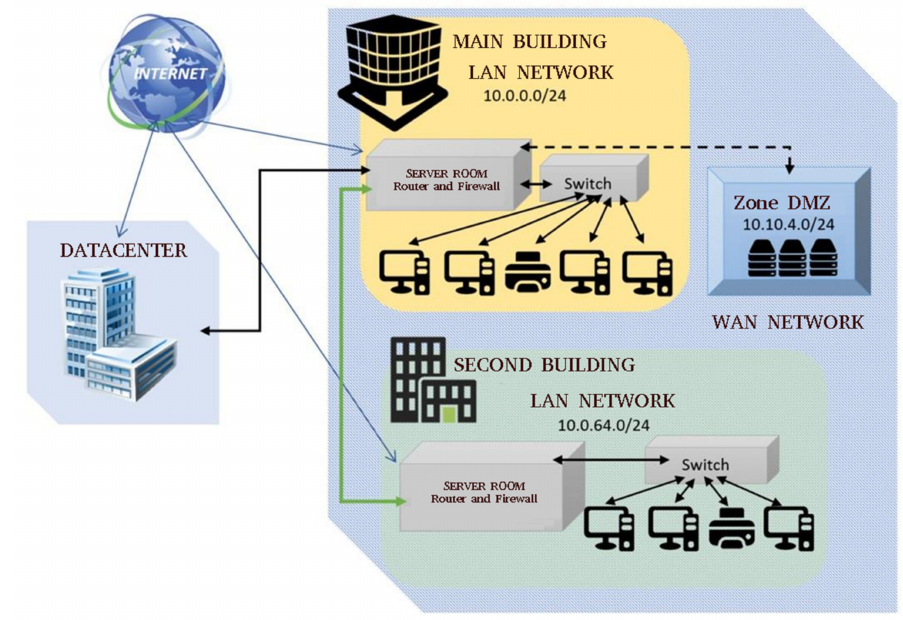
Figure 1. Graphical representation of the network topology layout for large multi-organization buildings with a direct connection to the data center. Source: own